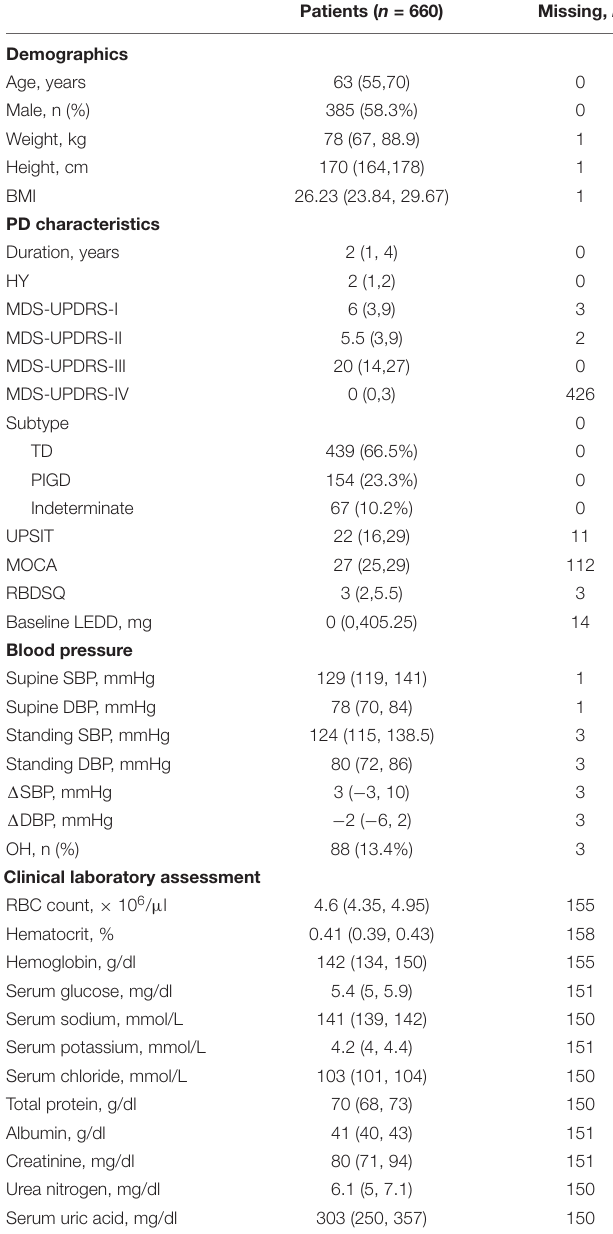
TABLE 1 | Demographical and clinical characteristics of